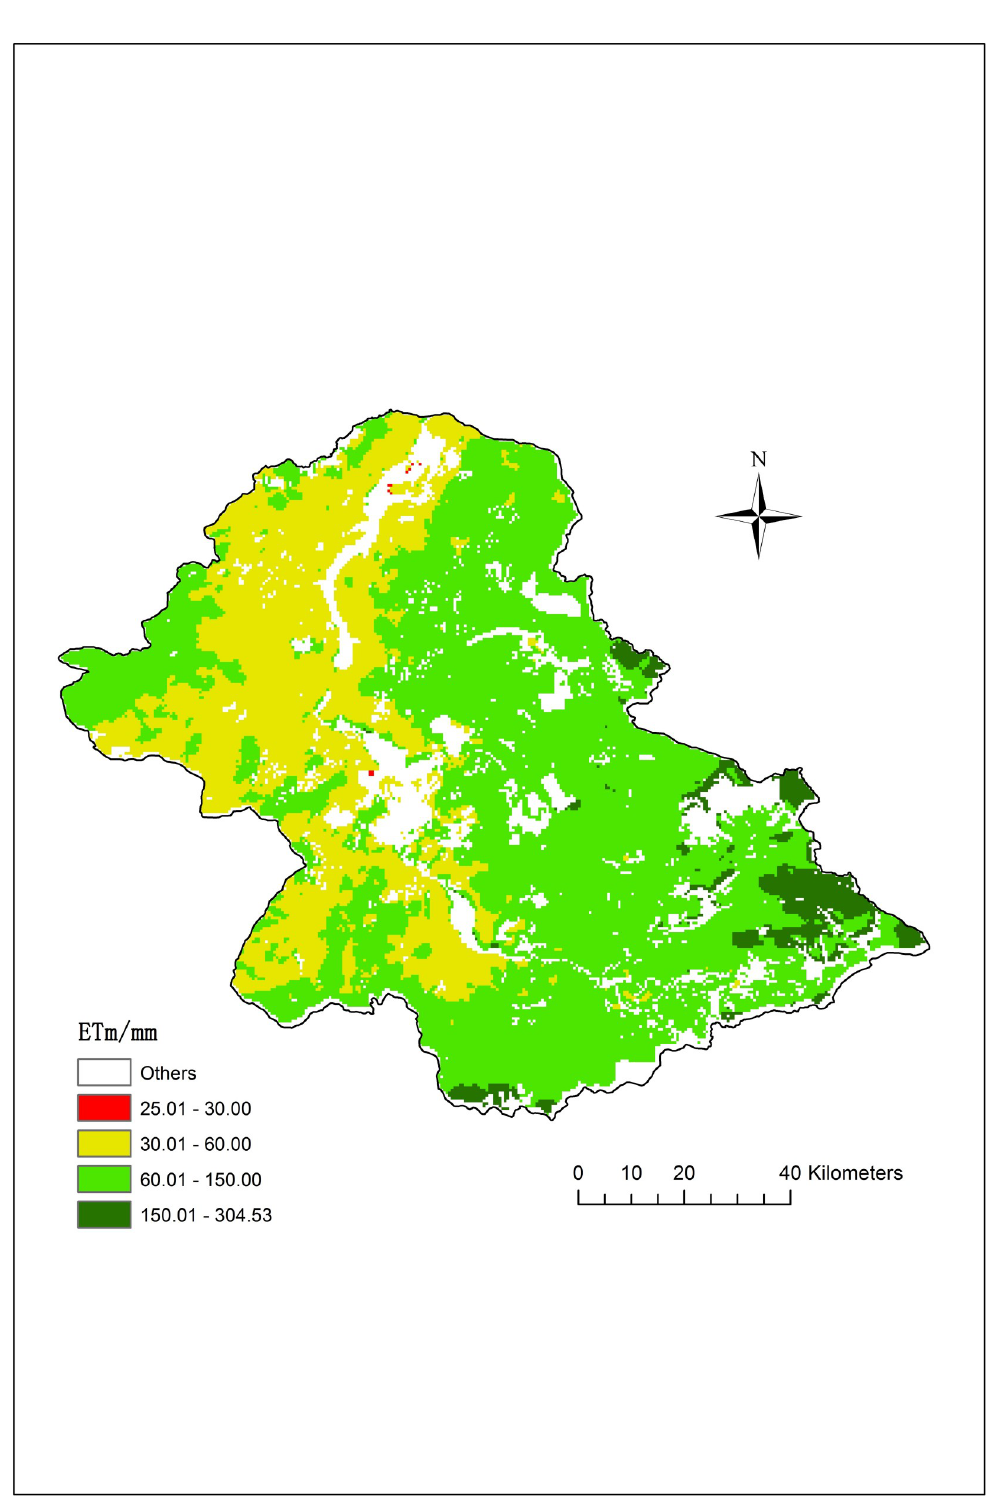
Fig 5. Average monthly ET in July during 2000–2017.